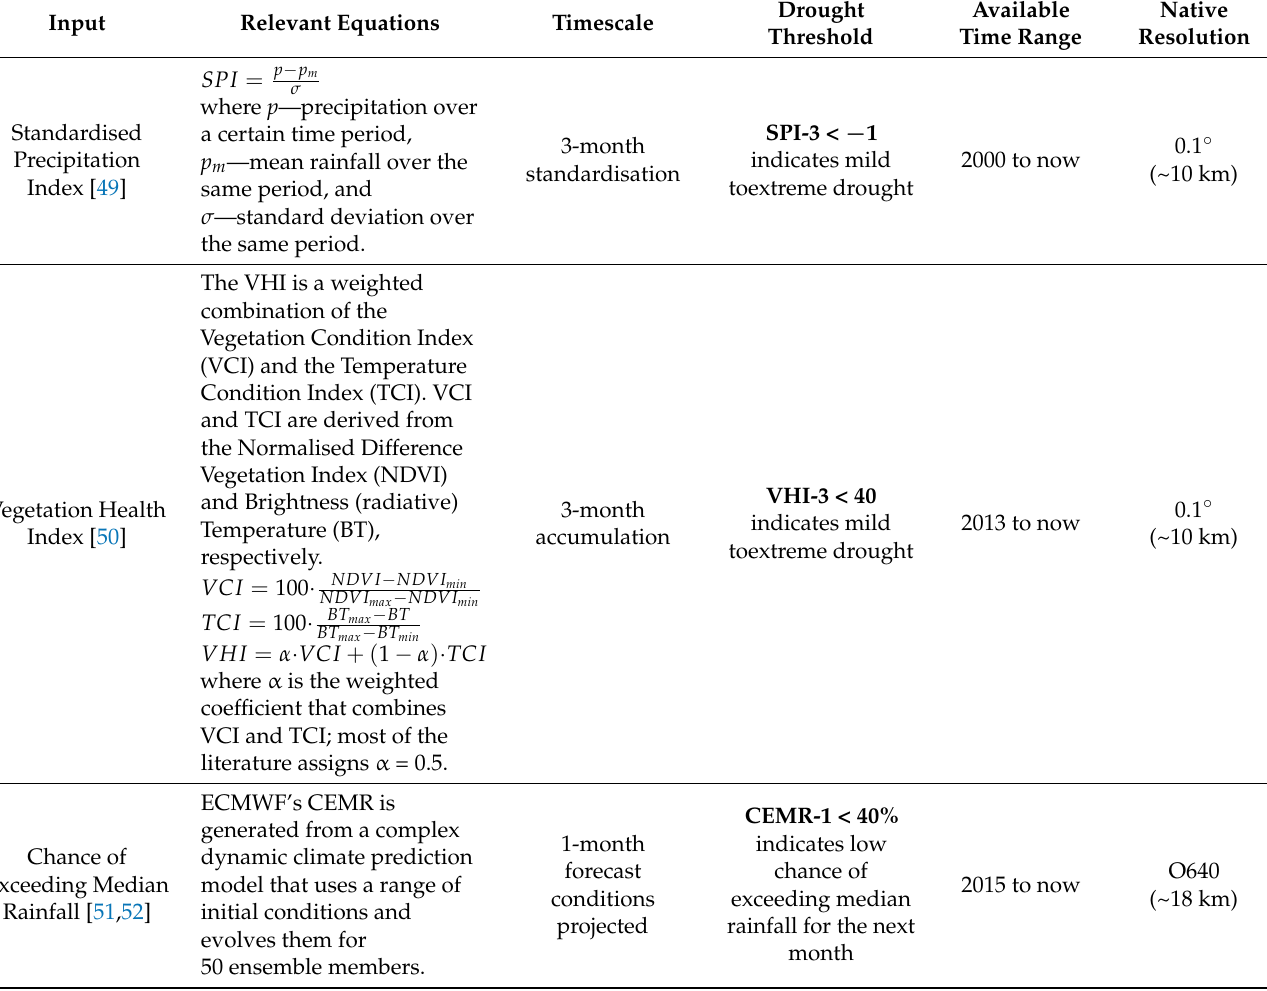
Table 1. Drought I-EWS inputs—relevant equations, timescales and drought